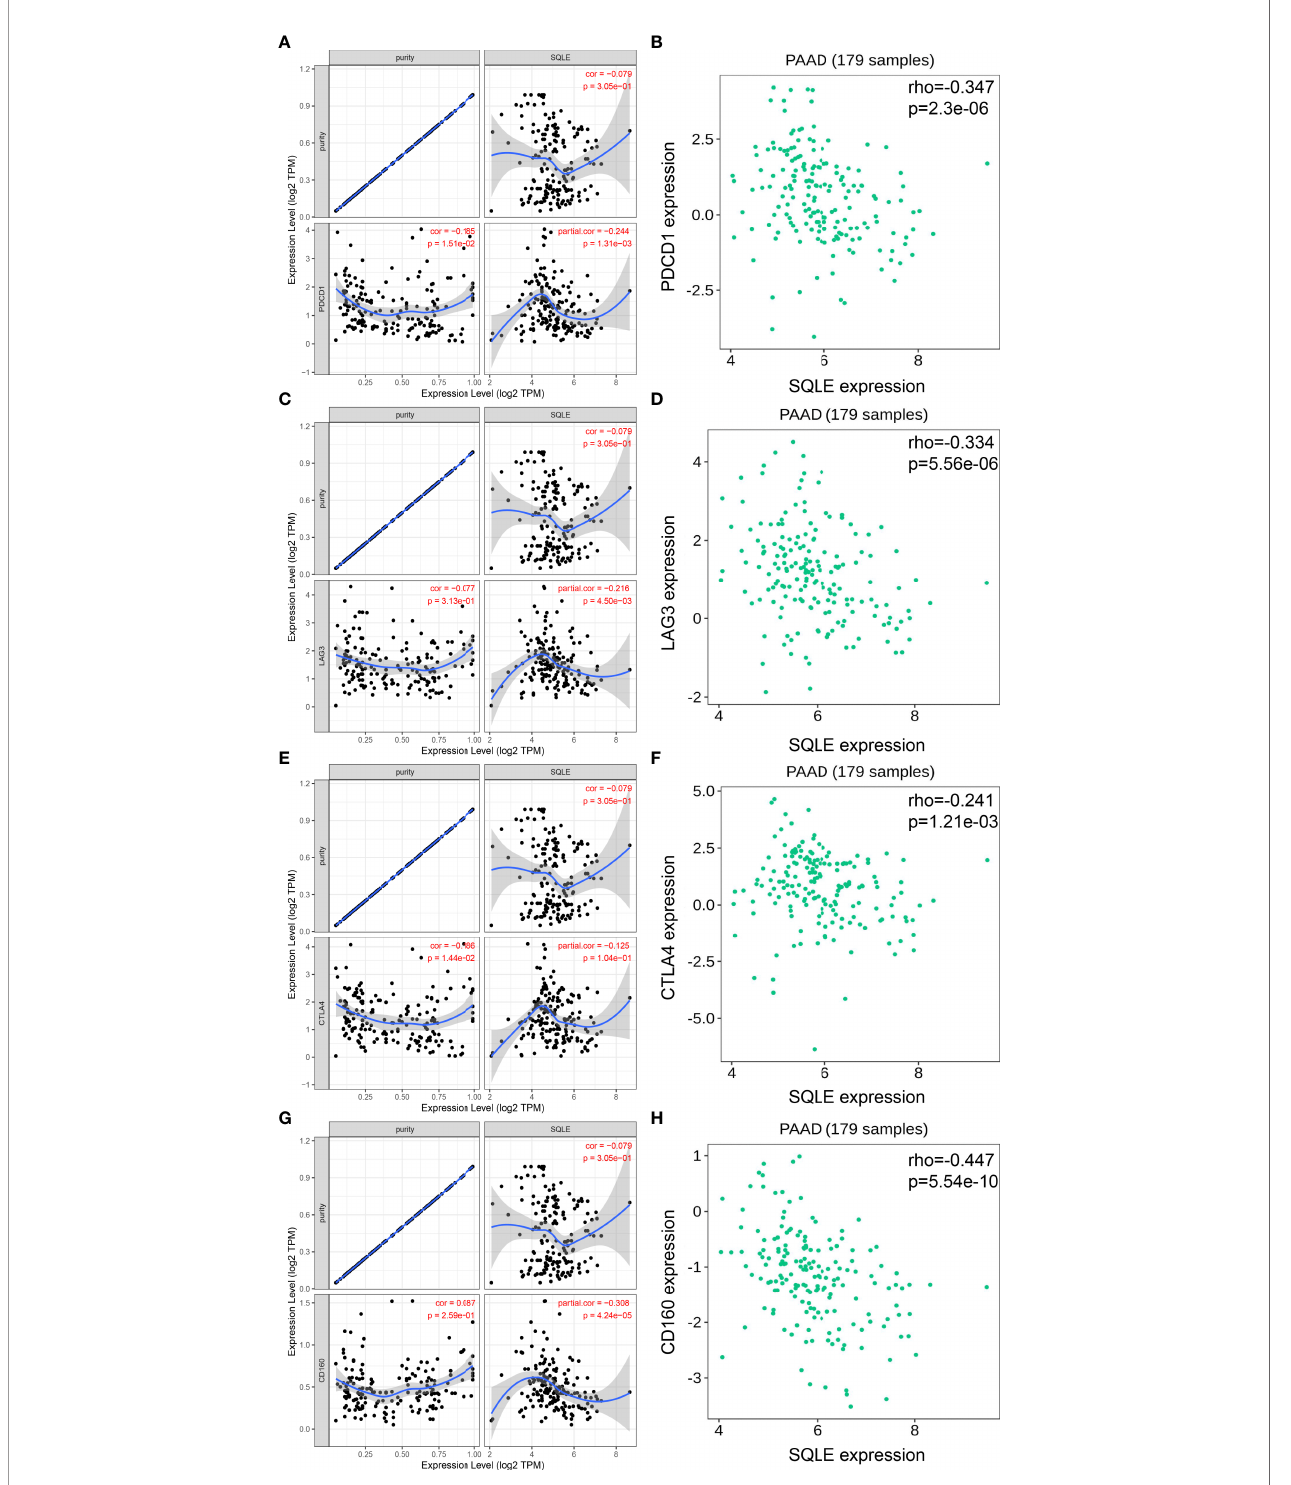
FIGURE 6 | SQLE expression is closely related to PDCD1, LAG3, CTLA4, and CD160 expression in PAAD. (A, B) Spearman correlation of SQLE expression with PDCD1 expression in PAAD adjusted by purity in TIMER (A) and TISIDB (B) . (C, D) Spearman correlation of SQLE expression with LAG3 expression in PAAD adjusted by purity in TIMER (C) and TISIDB (D) . (E, F) Spearman correlation of SQLE expression with CTLA4 expression in PAAD adjusted by purity in TIMER (E) and TISIDB (F) . (G, H) Spearman correlation of SQLE expression with CD160 expression in PAAD adjusted by purity in TIMER (G) and TISIDB (H)